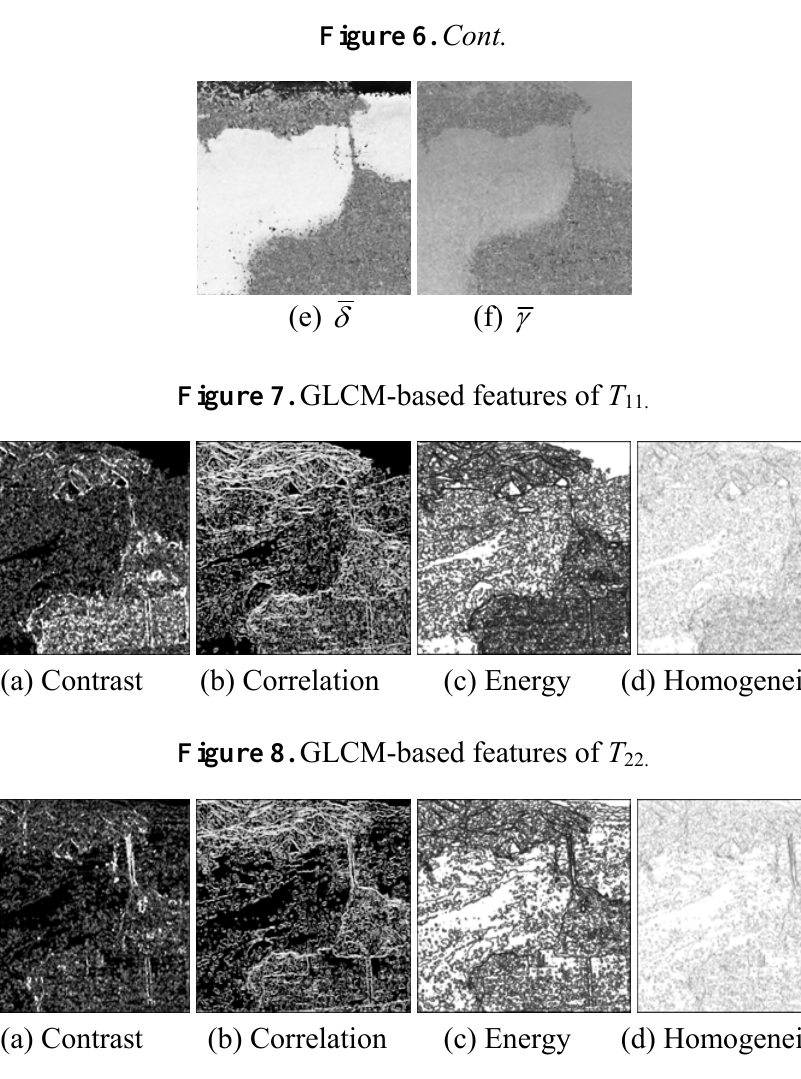
Figure 9. GLCM-based features of T